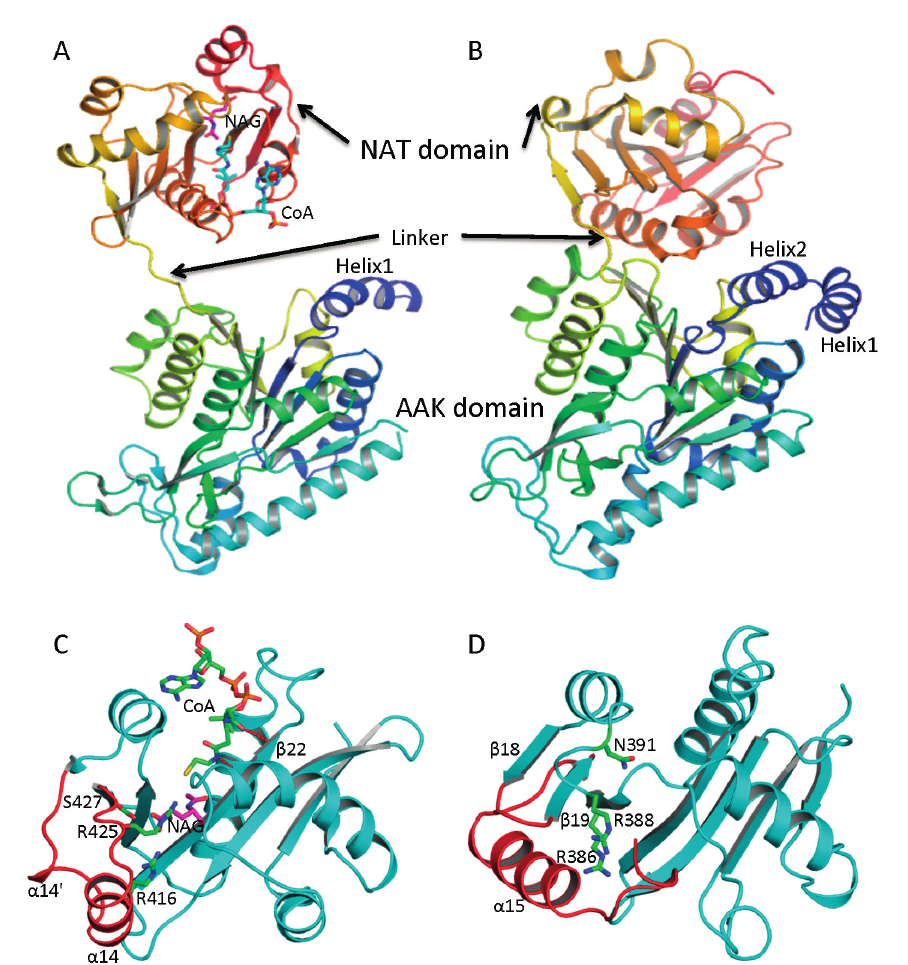
Figure 2. Ribbon diagram of subunit structures of ngNAGS and mmNAGS/K. ( A ) Subunit structure of ngNAGS in the absence of arginine. The structure consists of two domains, amino acid kinase (AAK) domain and N -acetyltransferase (NAT) domain, linked together by a flexible linker. No domain-domain interactions are observed within the subunit except via the linker; ( B ) Subunit structure of mmNAGS/K in the absence of arginine. The linker between AAK and NAT domains is shorter than that in ngNAGS. Some domain-domain interactions are observed. The structures are colored as a rainbow gradually changed from dark-blue for the N-terminus to red for the C-terminus; ( C ) Ribbon diagram of the NAT domain of ngNAGS. The bound CoA and NAG are shown in green and magenta sticks, respectively. Three residues, R416, R425 and S427, which are involved in binding NAG, are shown as green sticks; and ( D ) Ribbon diagram of NAT domain of mmNAGS/K. The last helix, α 15, occupies the equivalent position of α 14 of ngNAGS. Three residues, R386, R388 and N391, which are potentially involved in binding NAG, are shown as green sticks. The major differences in the NAT domains between ngNAGS and mmNAGS/K are colored in